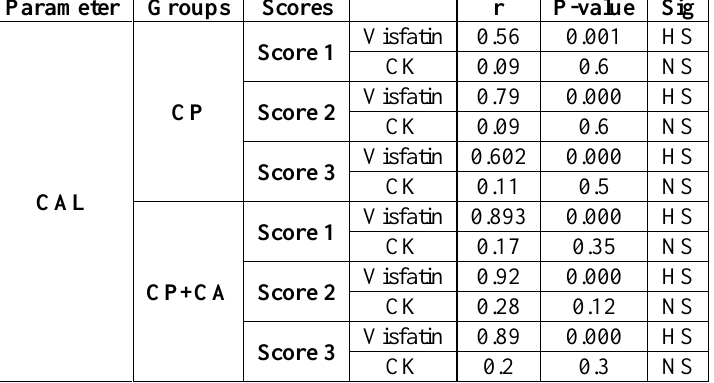
Table 7: Pearson's Correlation Coefficient (r) between CAL and the levels of salivary CK enzyme and visfatin for each study group Parameter